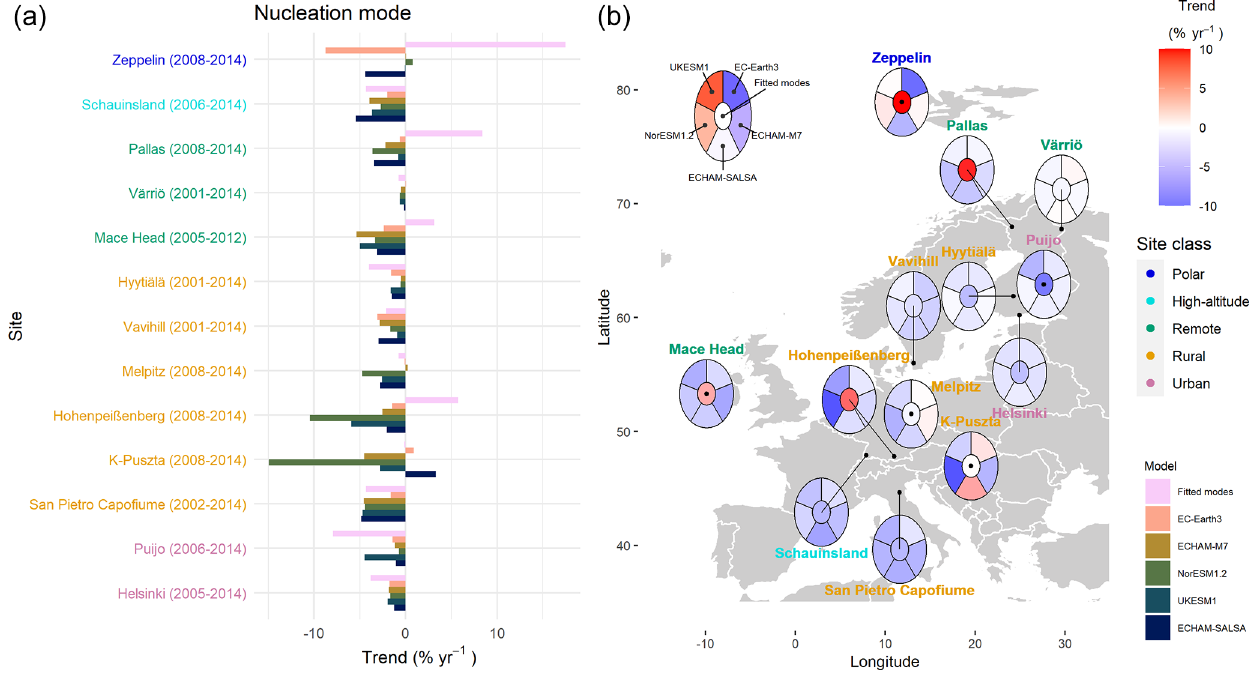
Figure 6. Long-term trend estimates for measured and modelled nucleation mode number concentration. (a) Bar plot of trends for different sites. The sites ( y axis) are arranged by site class and within site class most northerly to most southerly. (b) Estimated trends presented on the map. The colour of the central part follows the trend of the fitted modes. Trends have been calculated using the Sen–Theil estimator and complemented with bootstrap confidence intervals (see Sect.